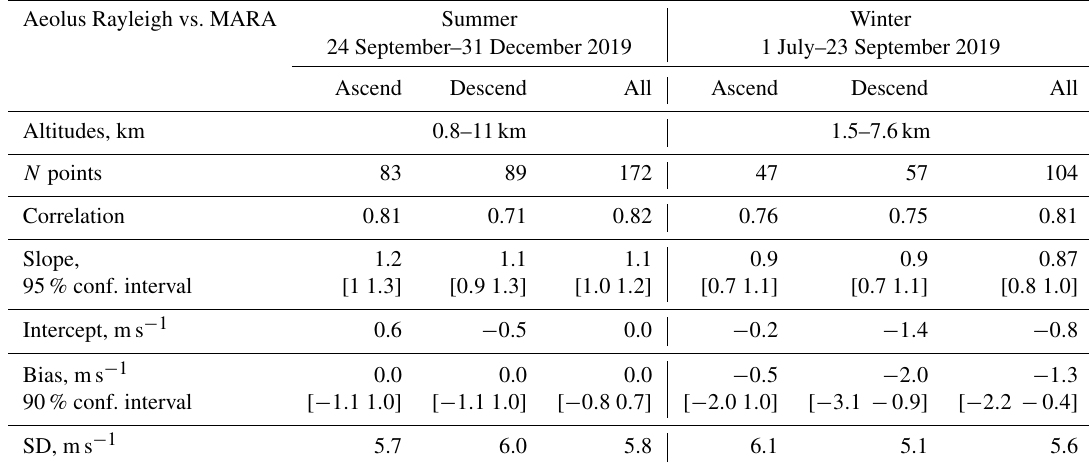
Table 2. Aeolus Rayleigh–MARA HLOS wind comparison. Aeolus Rayleigh vs. MARA